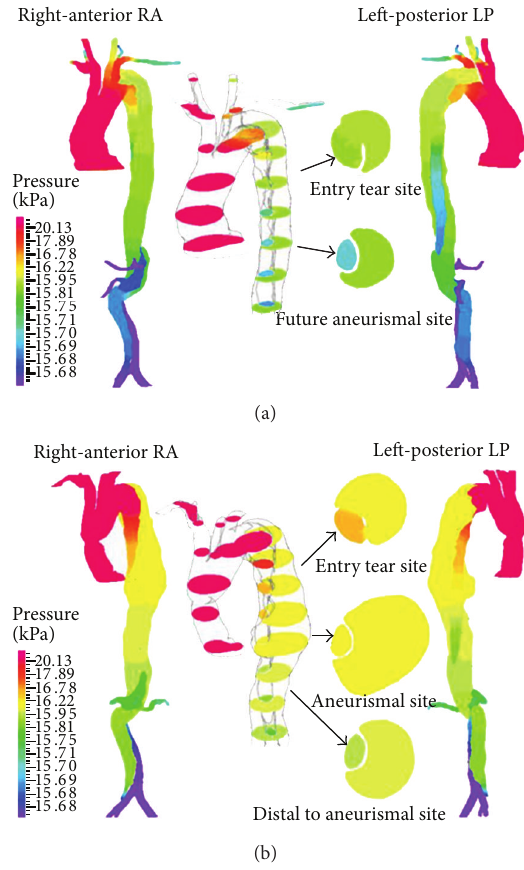
Figure 3: Pressure contour plots adapted from Tse et al. [7]. (a) The preaneurismal aorta (before formation of the luminal aneurysm); (b) the postaneurismal aorta (after formation of luminal aneurysm). In the middle, an interior view of random axial cross-sections shows pressure difference in true and false